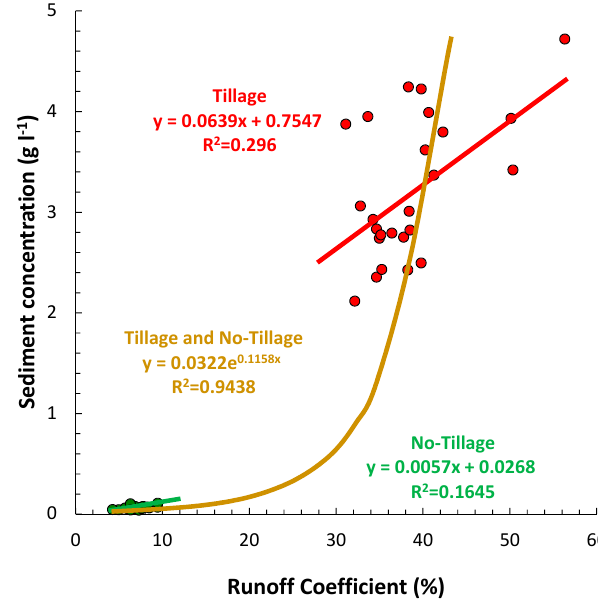
Figure 9. Relation between runoff coefficient (%) and soil erosion (Mg ha − 1 y − 1 ) for Tillage and No-Tillage plots (n 25 + 25) at the experimental station “La Cañadeta”.